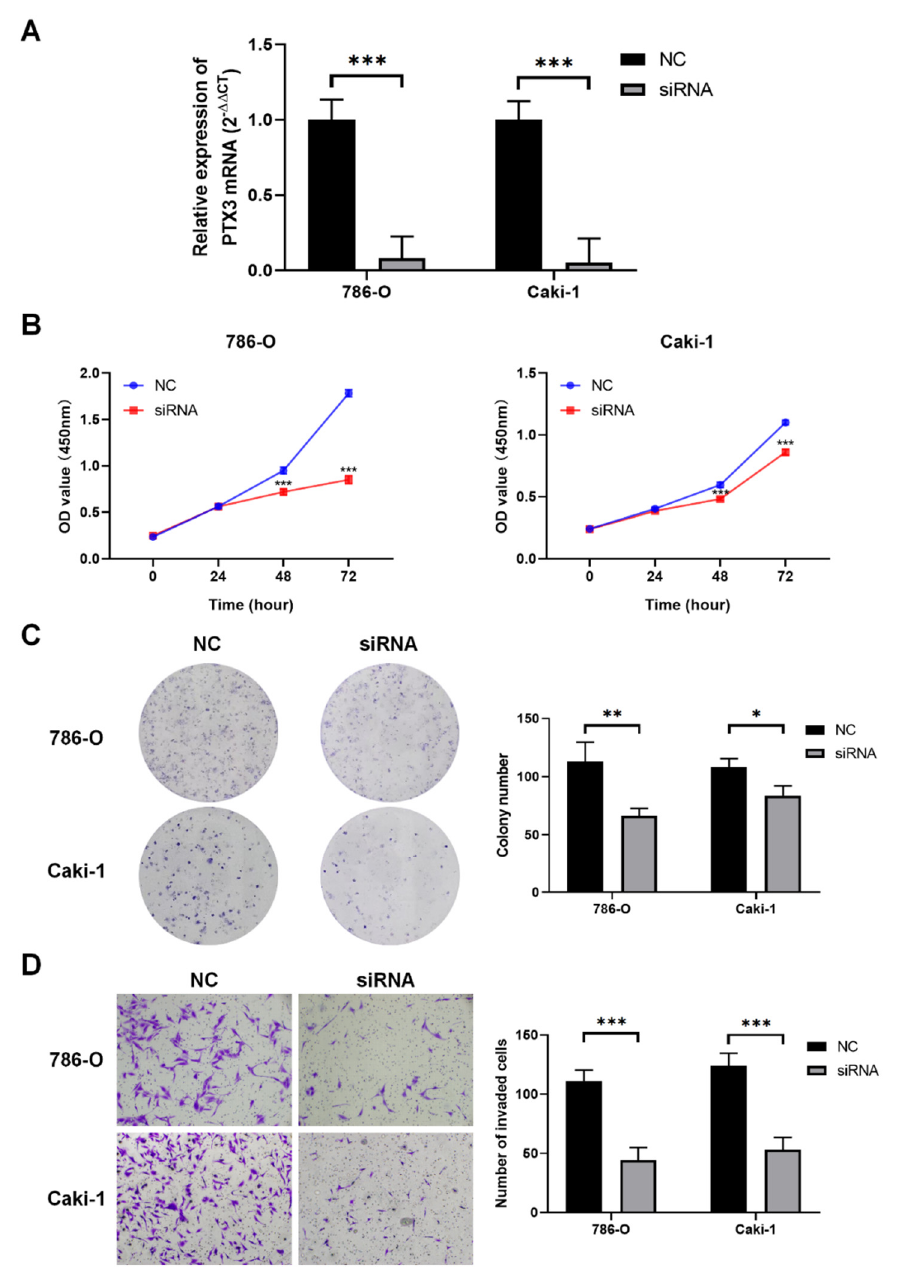
Figure 10. PTX3 function in KIRC: ( A ) The interference efficiency of PTX3 siRNA was evaluated by qRT-PCR; ( B , C ) KIRC cells’ proliferation was determined by CCK-8 ( B ) and colony assays ( C ); ( D ) blocking PTX3 expression could inhibit KIRC cell migration and invasion. (Data are shown as the mean ± SD of three replicates. * p < 0.05, ** p < 0.01, *** p < 0.001 by ANOVA test).